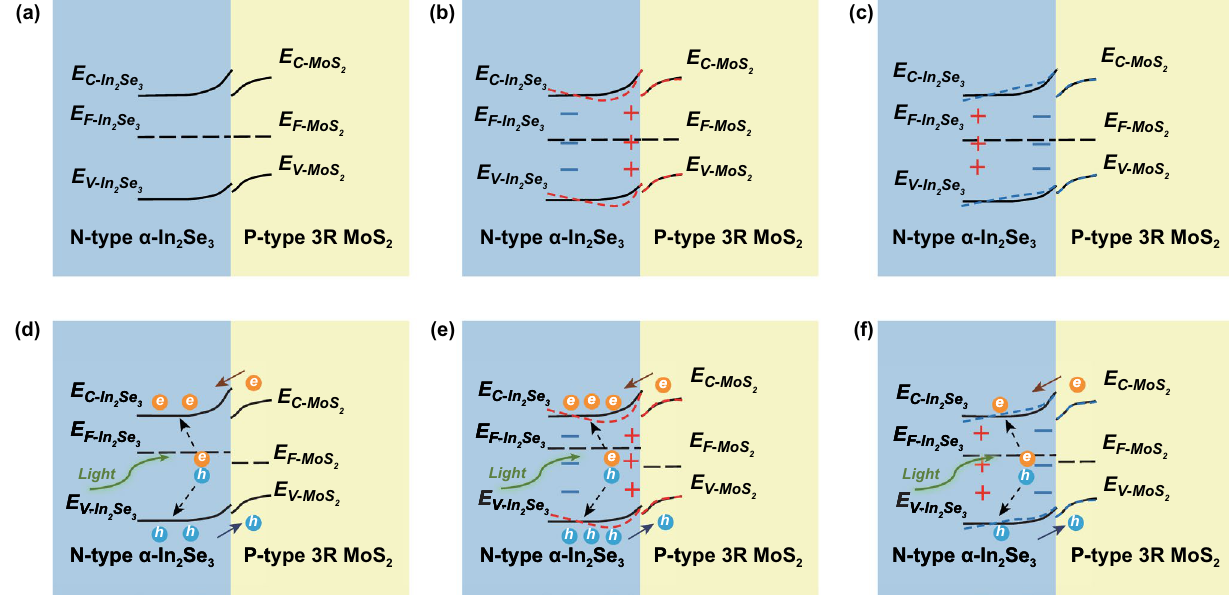
Fig. 5 The energy band diagrams for the α-In 2 Se 3 /3R MoS 2 heterojunction with\without the strains and light illumination. The energy band diagram a in thermal equilibrium with zero light illumination and no external strain b under zero light illumination, a tensile strain c under zero light illumination, a compressive strain d under light illumination, no strain applied e under light illumination, a tensile strain f under light illu- mination and a compressive